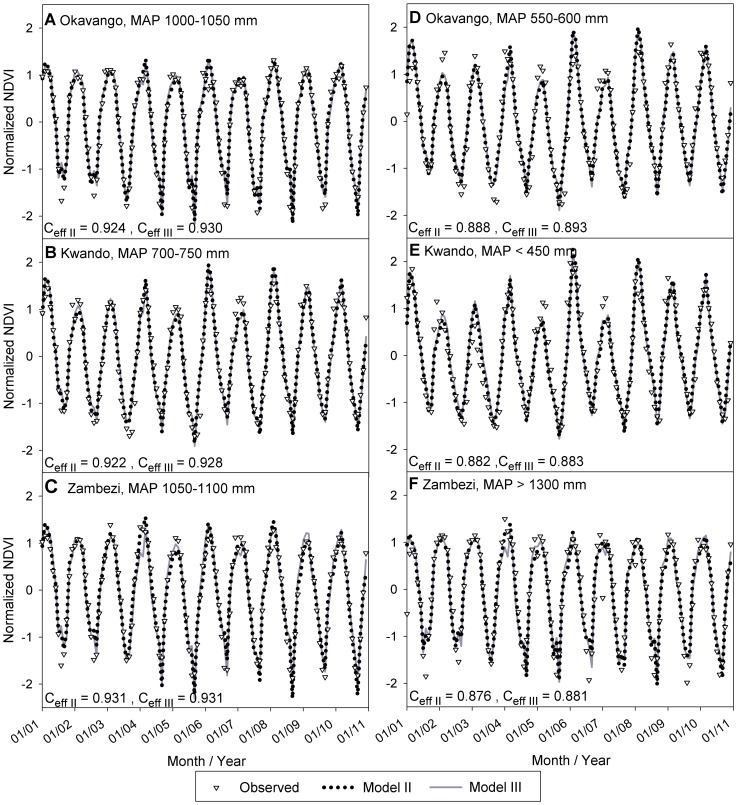
Comparison of model II and III results and measured NDVI.Best-performing (A,B,C in left column) and worst-performing (D,E,F in right column) polygons in each watershed are shown.